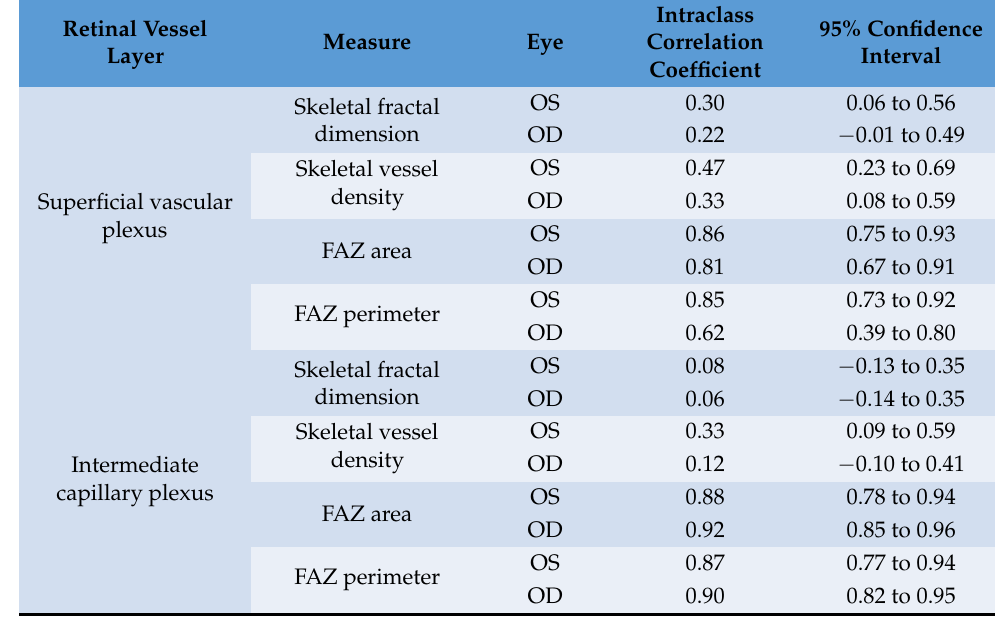
Table 2. Intraclass correlation coefficient of the superficial vascular plexus and intermediate capillary plexus blood flow measures, with the corresponding 95% confidence interval. OS: left eye; OD: right eye; FAZ: foveal avascular